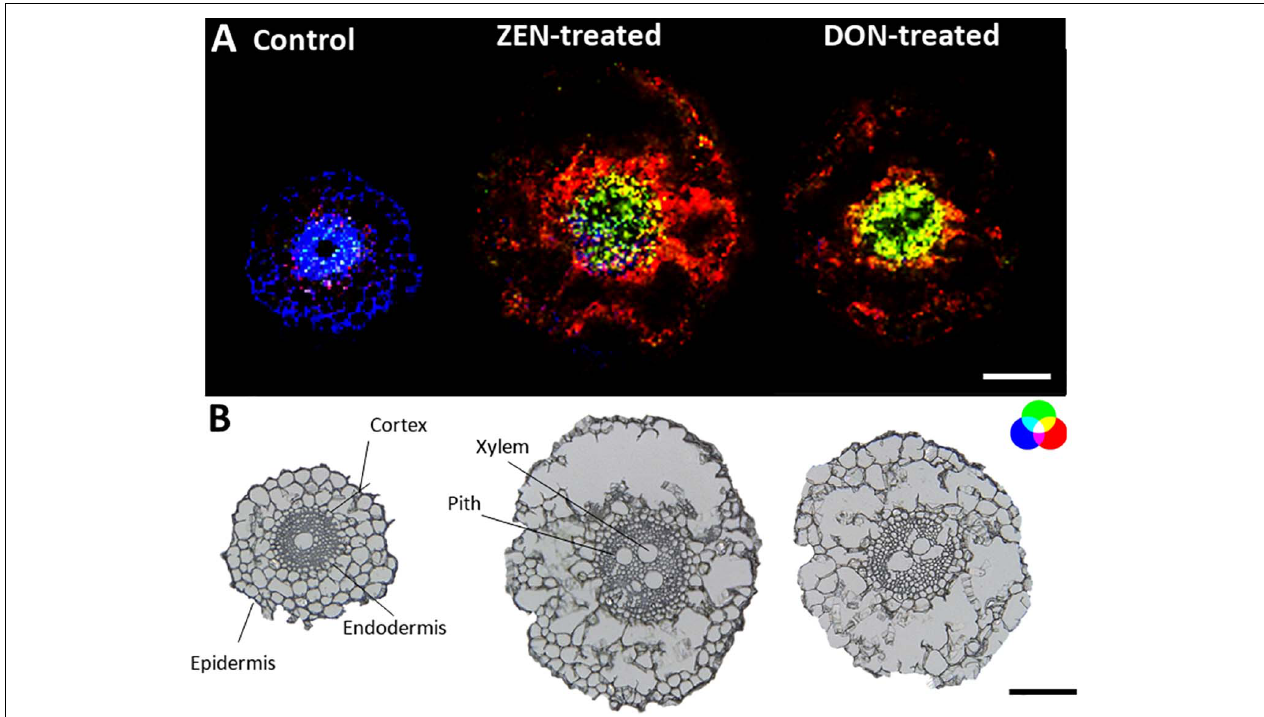
FIGURE 2 | Tissue-specific changes induced in the wheat root by mycotoxins accumulation. (A) RGB overlay of m/z images of PC (34:3) [M + K] + , m/z 794.5099 (red), and DGDG (34:2) [M + K] + m/z 955.5717 (green) accumulated in the cortex cells and in the central stele of treated samples, respectively. Distribution of tryptophyl-alanine, [M + NH 4 ] + m/z 293.1608 (blue), exclusively located in the control root. (B) Optical images of roots with major morphological features labeled. The structural integrity of some roots was damaged due to the fragility of the tissue. The large vacuole in the root cell caused the cells to rupture due to the temperature change during the thawing process. AP-SMALDI MS images were obtained at 7 µ m imaging step size and normalized to the total ion current on a 0-60% intensity scale. Scale bars: 200 µ